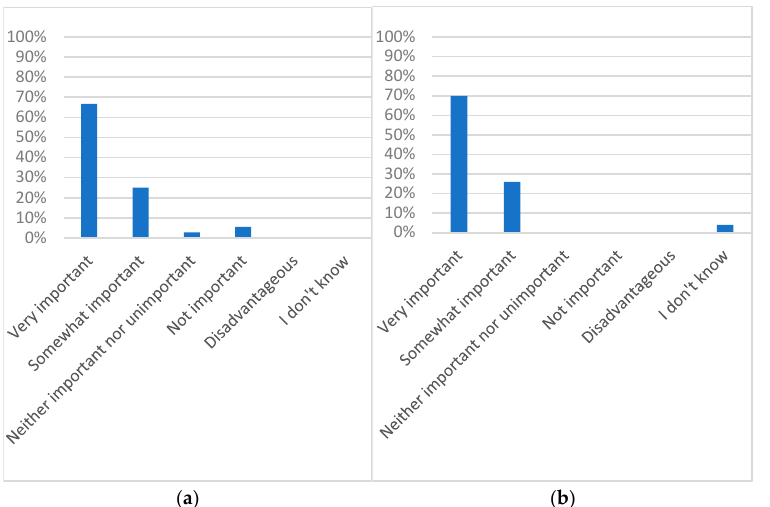
Figure 1. How important is information (cyber) security to your daily job and activities? ( a ) Europe; ( b ) Asia.